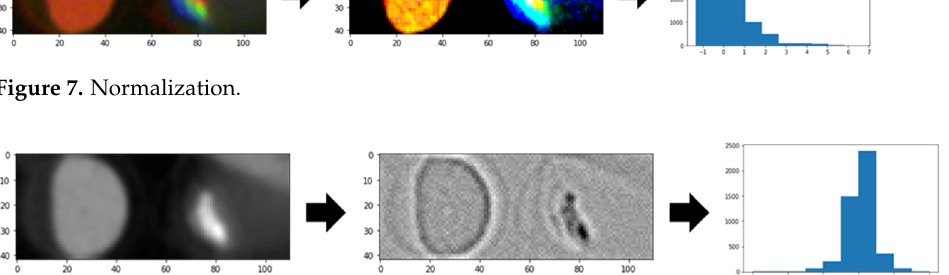
Figure 8. Laplacian operator.